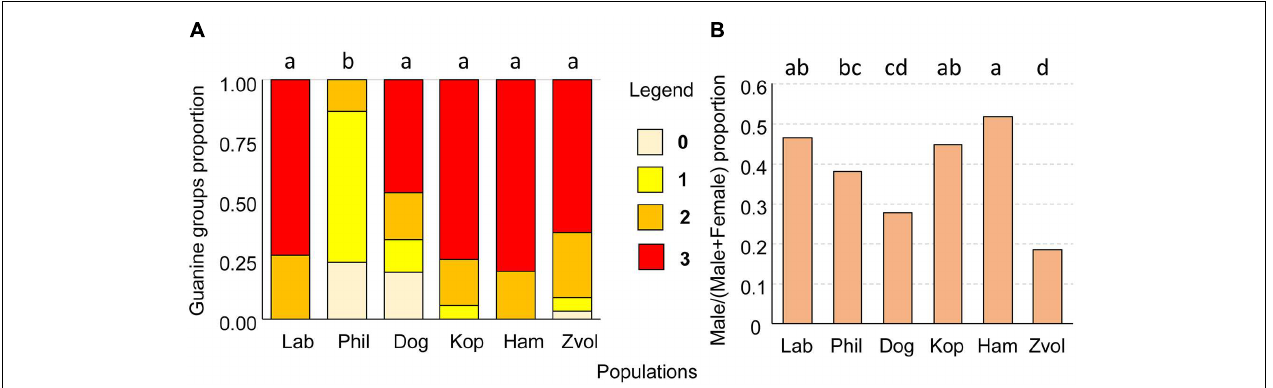
FIGURE 10 | (A) The proportion of guanine waste product granules in T. putrescentiae ; (B) comparison of sex ratios, male/(male + female) in examined populations of T. putrescentiae . Statistically significant differences ( α = 0.05) in multiple comparisons are indicated by different letters. Abbreviations for the T. putrescentiae populations are listed in Table 1 . (0) no guanine granules, (1) low number, granules fill less than 25% of the hysterosoma, (2) intermediate, granules fill between 25 and 50% of the hysterosoma, and (3) massive, granules fill more than 50% of the